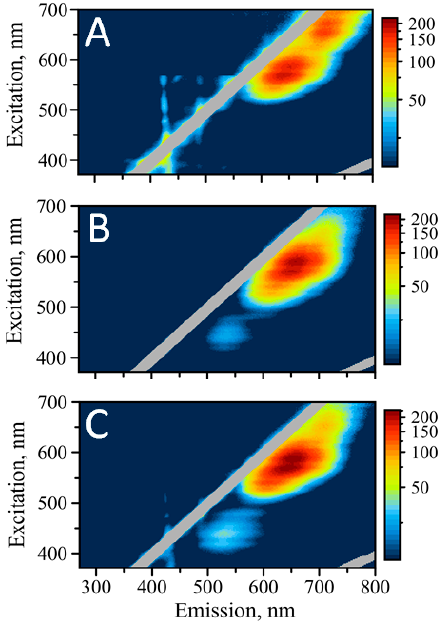
Figure 3. Excitation/emission maps of silver nanoclusters with excitation in the visible: ( A ) AgNC templated on C 12 , ( B ) AgNC templated on SD9-OEC 12 , ( C ) AgNC templated on SD9-BEC 12 .